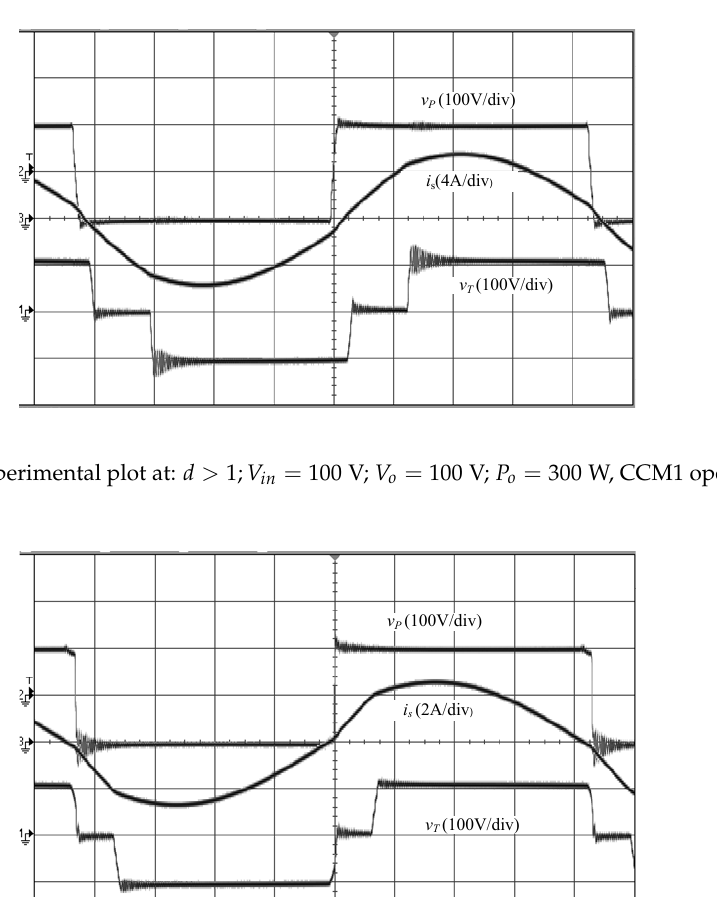
Figure 12. Experimental plot at: d = 1; V in = 110 V; V o = 100 V; P o = 300 W, CCM1 operation.